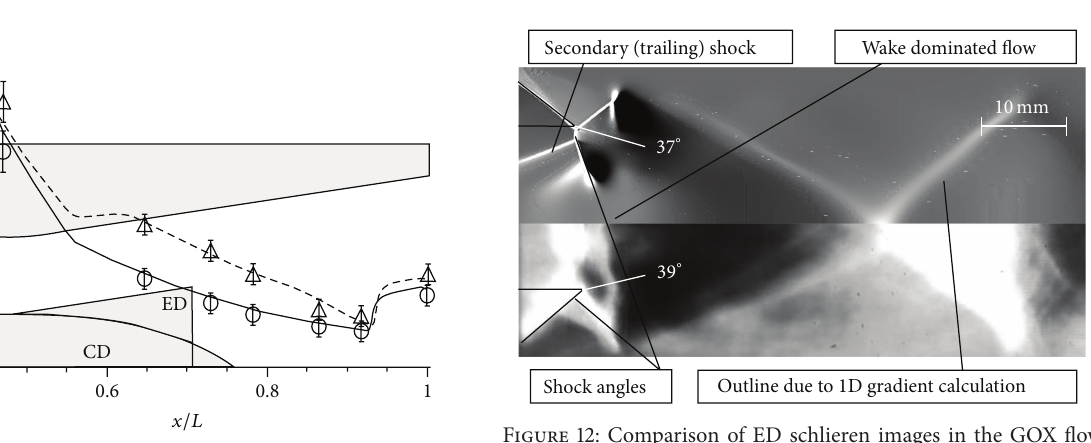
Figure 12: Comparison of ED schlieren images in the GOX flow condition.